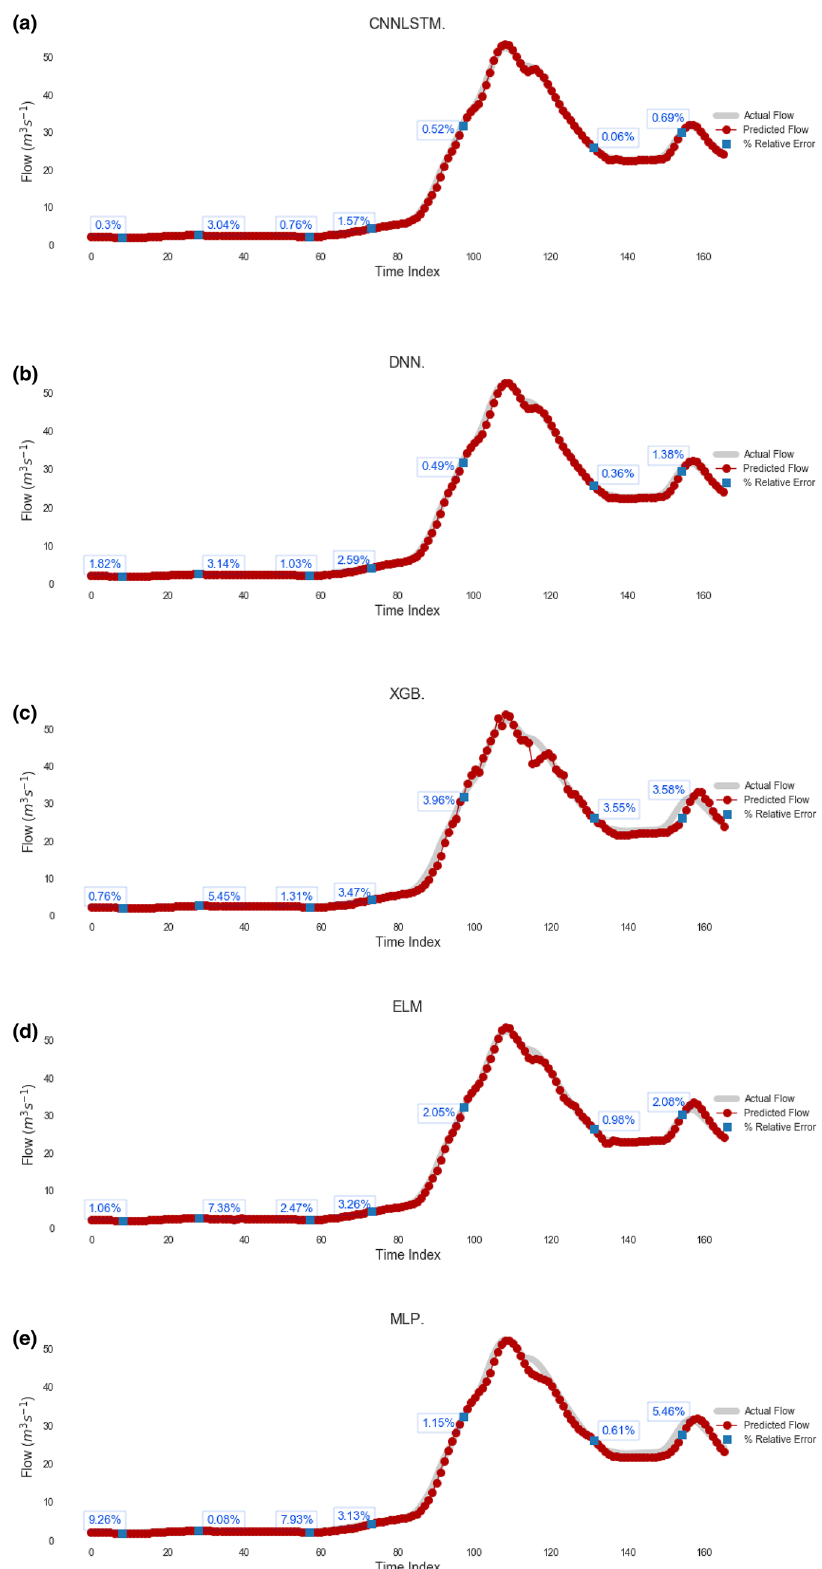
Figure 10. Hydrograph of predicted versus actual streamflow (Q, m 3 s −1 ) from ( a ) CNN-LSTM model during test period (2 Weeks) compared with standalone model ( b ) Deep Neural Network (DNN), ( c ) Extreme Gradient Boosting Regression Model (XGB), ( d ) Extreme Learning Machine (ELM) and ( e ) Multi-Layer Perceptron (MLP) for Teewah Creek. The relative error are shown in blue